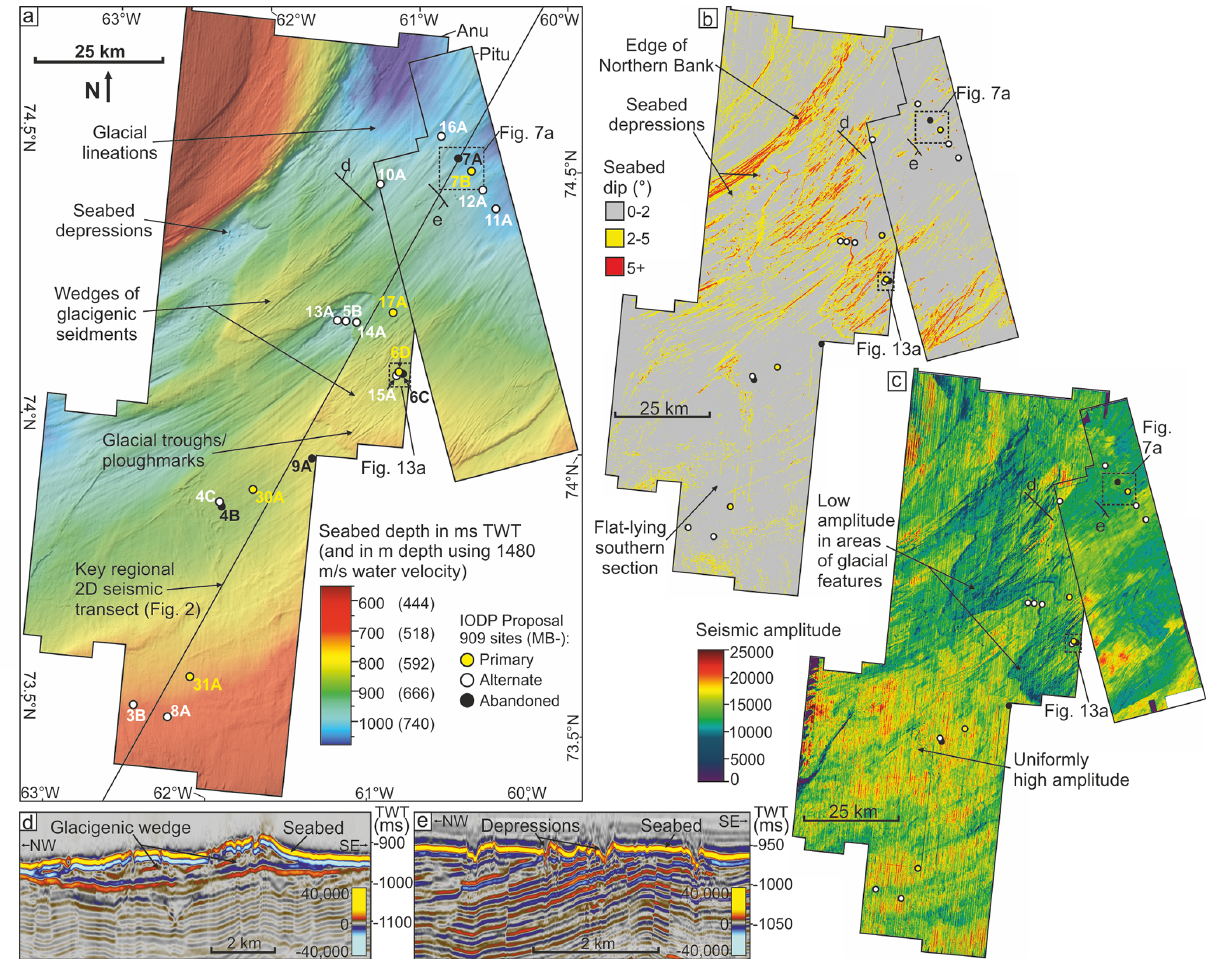
Figure 6. Seabed mapping. (a) A seabed structure map across the 3D seismic coverage shown in both two-way time and converted metric depth, with the bathymetry data from Newton et al. (2017) shown beneath. (b) A dip attribute map across the 3D seismic coverage that has been filtered to display features by dip severity, with colours amber and red relating to moderate (2–5 ◦ ) and high (5 + ◦ ) risk respectively. (c) An amplitude attribute extraction map at the seabed surface across the 3D seismic extent showing the variation in amplitude between areas dominated by or free from glacigenic features. The locations of both active and abandoned IODP Proposal 909 sites are shown in panels (a) – (c) along with the locations of panels (d) and (e) , Figs. 7a and 13a. (d) A seismic cross section from the Anu survey showing an example of a glacigenic wedge which is topped by glacial lineations. (e) A seismic cross section from the Pitu HR survey showing the unconformable nature of the seabed as well as seabed depressions that likely represent iceberg pit marks (cf. Brown et al.,